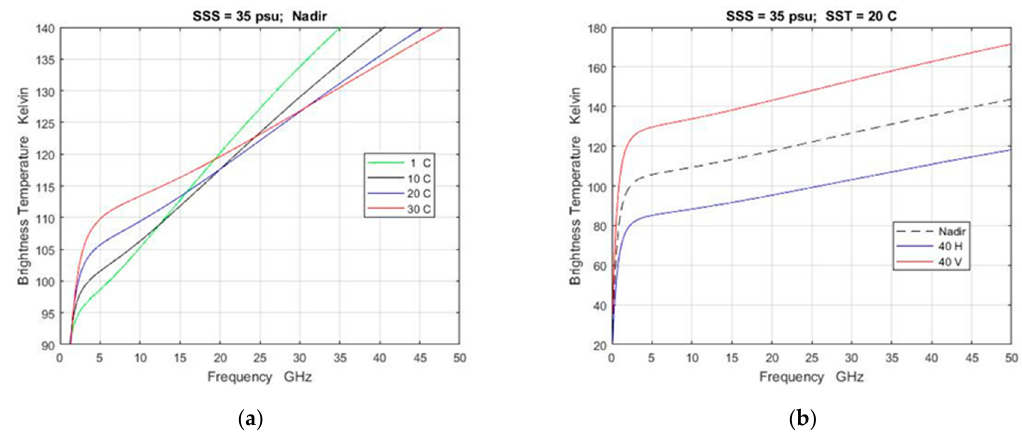
Figure 9. Brightness temperature as a function of frequency: ( a ) At nadir and several values of SST; ( b ) SST = 20 ◦ C for nadir and 40 ◦ incidence angle. All curves are for SSS = 35 psu, zero wind speed (flat surface) and use the Klein-Swift model function [19] for the dielectric constant of sea water.